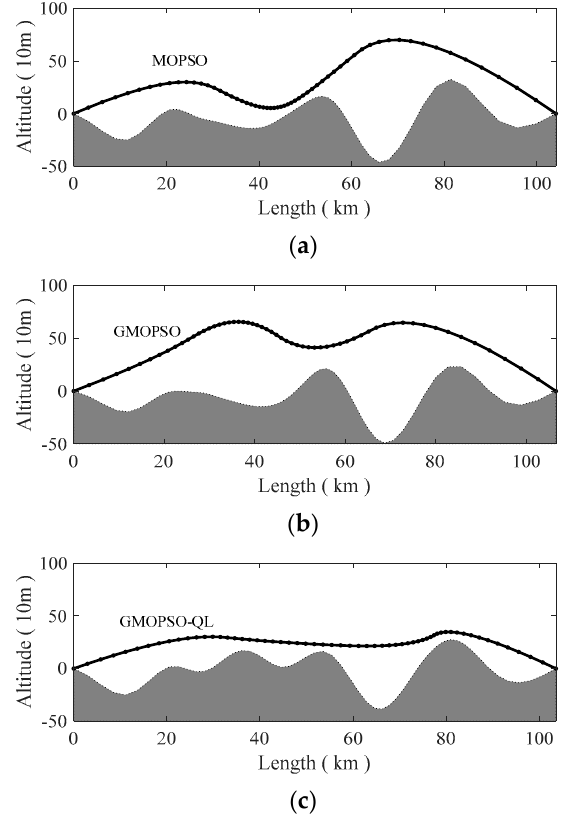
Figure 5. Vertical profiles of the best paths in Case 1: ( a ) MOPSO, ( b ) GMOPSO, ( c ) GMOPSO-QL.